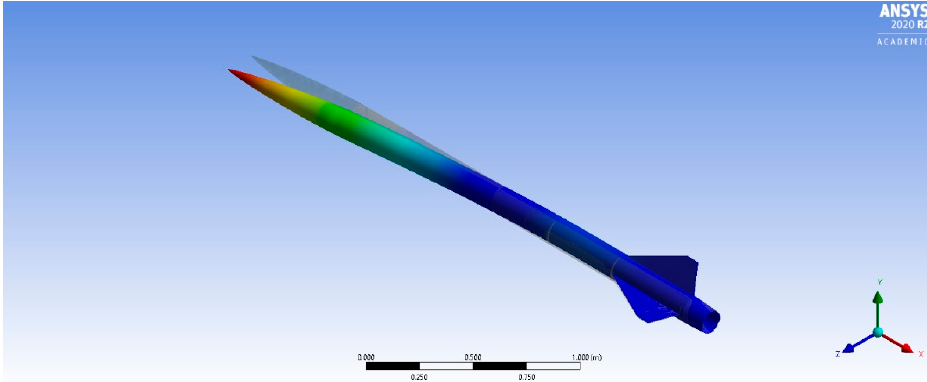
Figure 27. First-Order Bending Mode Shape (X–Z Plane).